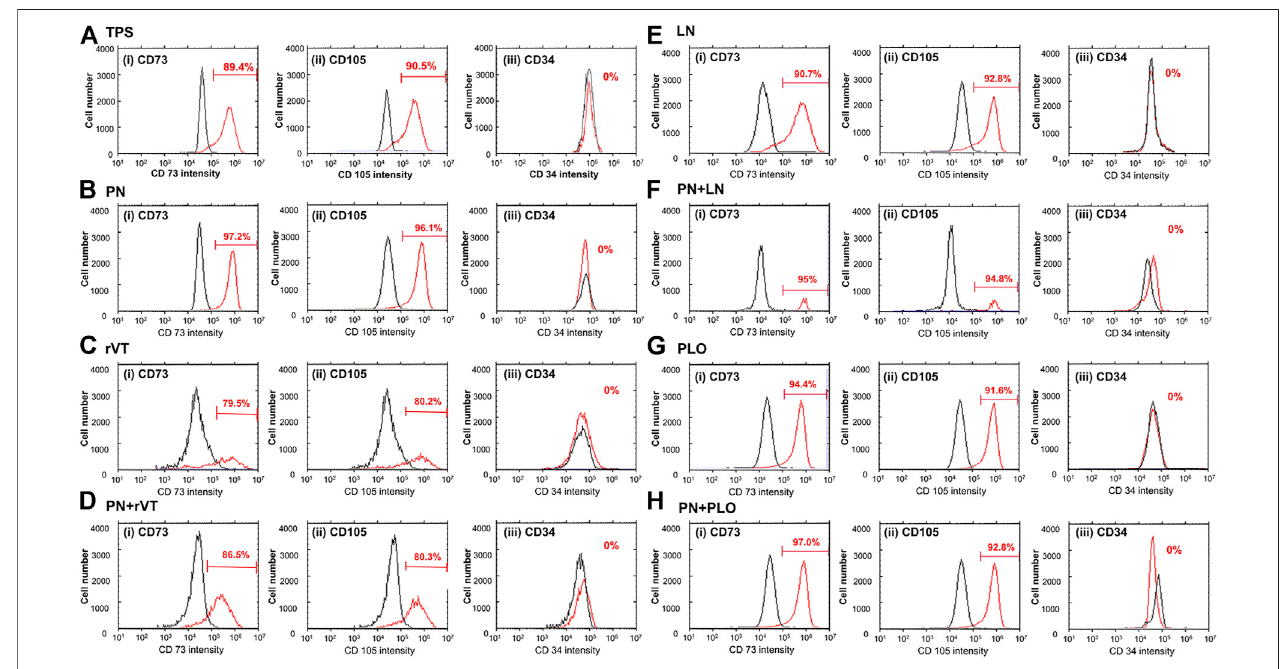
FIGURE4| ExpressionofMSCmarkers[CD73 (i) and CD105 (ii) ]and hematopoietic marker [CD34 (iii) ] inDPSCsculturedonTPS (A) ,TPS-PN (B) ,TPS-rVT (C) , TPS-PN-rVT (D) , TPS-LN (E) , TPS-PN-LN (F) , TPS-PLO (G) and TPS-PN-PLO plates (H) .